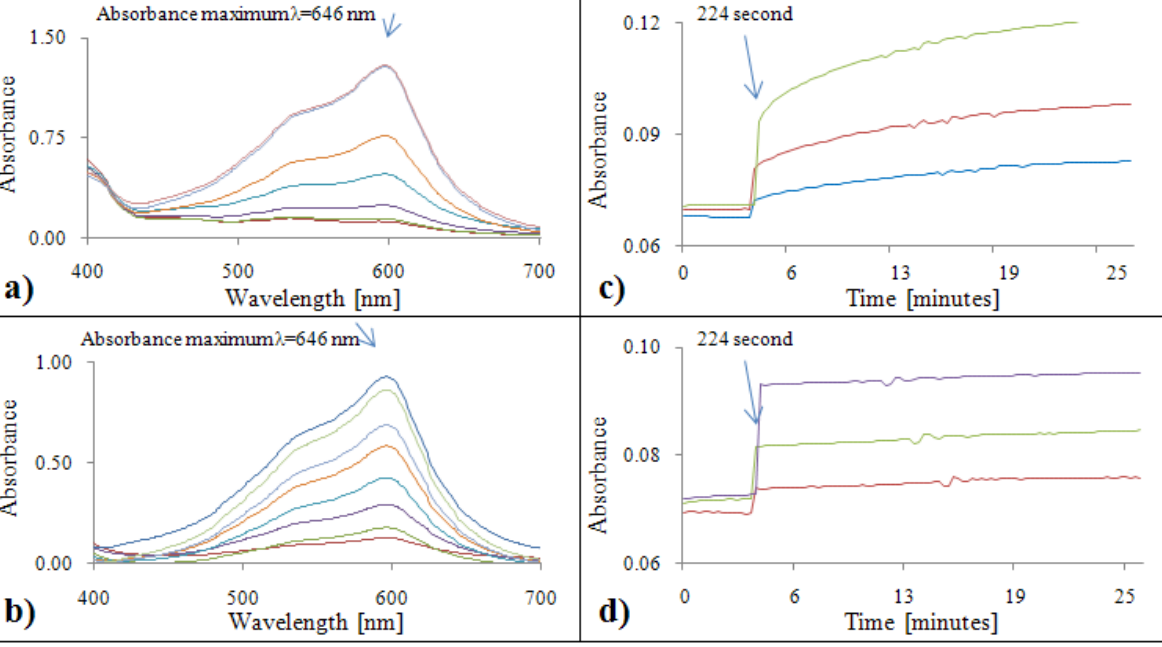
Figure 4. DMPD absorption spectra (450 – 700 nm) for gallic acid (a) and Trolox ® (b) . Dependence of absorbance of DMPD with gallic acid (c) and Trolox ® (d) on